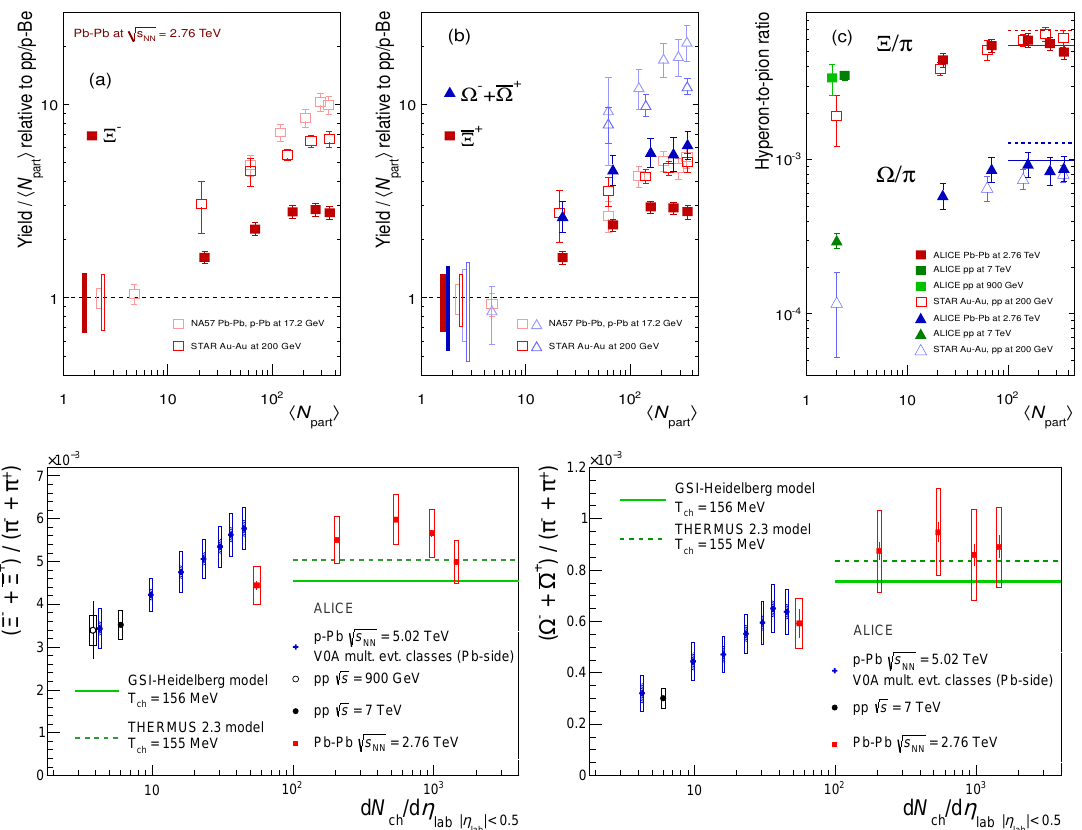
Figure 21. Top : ( a , b ) Normalized (to p + p or p + Be) yields of multistrange baryons per participants (cid:10) (cid:11) N part at midrapidity as a function of for the LHC (full symbols), RHIC, and SPS (open symbols) data. Boxes on the dashed line at unity indicate the statistical and systematic uncertainties on the p + p (cid:10) (cid:11) N part or p + Be reference; ( c ) Hyperon-to-pion ratios as a function of for Pb + Pb, Au + Au, and p + p collisions at LHC and RHIC energies. The lines are the thermal model [309] (full line) and [328] + (dashed line) predictions. Reproduced from Ref. [329]; Bottom : ( left ) ( Ξ − + Ξ )/( π + + π − ) and ( right ) + ( Ω − + Ω )/( π + + π − ) ratios as functions of (cid:104) dN ch / d η (cid:105) for p + p , p + Pb, and Pb + Pb collisions at the LHC. The Pb + Pb data points [329] represent, from left to right, the 60%–80%, 40%–60%, 20%–40%, 10%–20%, and 0%–10% centrality classes. The chemical equilibrium predictions by the GSI-Heidelberg [309] and the THERMUS 2.3 [328] models are represented by the horizontal lines. Reproduced from Ref. [330]. The two bottom plots represent a comparison between the hyperon-to-pion ratios from p + p , p + Pb, and Pb + Pb collisions. Interestingly, the ratios in p + Pb collisions increase with multiplicity from the values measured in p + p to those observed in Pb + Pb. The rate of increase is more pronounced for particles with higher strangeness content. Let us note that the Grand canonical statistical description of Pb + Pb data shown as full and dashed lines in Figure 21 may not be appropriate in small multiplicity environments such as those produced in the p + Pb case. It appears that for the latter case, the evolution of hyperon-to-pion ratios with the event multiplicity is qualitatively well described by the Strangeness Canonical model implemented in THERMUS 2.3 [328]. In this case, a local conservation law is applied to the strangeness quantum number within a correlation volume V c , while treating the baryon and charge quantum numbers grand-canonically within the whole fireball volume V